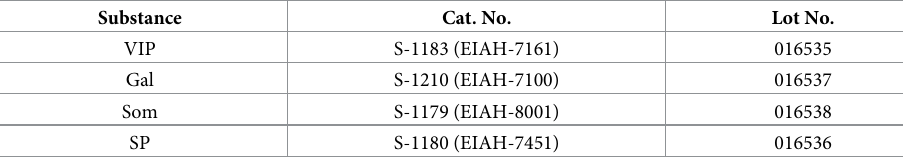
Table 4. Enzyme immunoassay kits used (Peninsula Laboratories Inc.). Substance Cat. No.